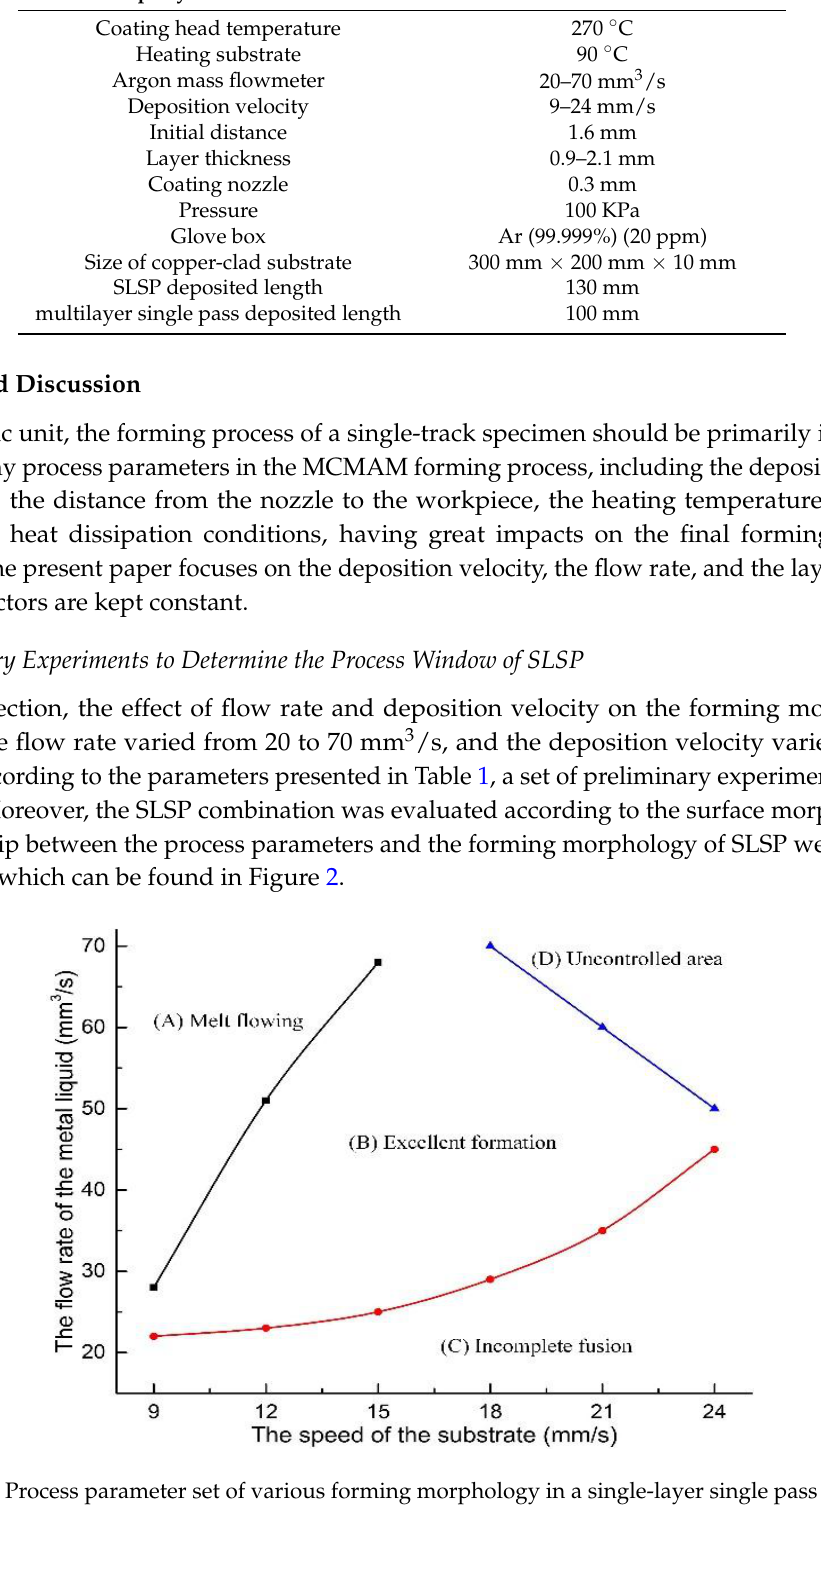
( d ) Figure 3. Various forming morphology with different combinations of process parameters. ( a ) Melt flowing. ( b ) Excellent formation. ( c ) Incomplete fusion. ( d ) Uncontrolled area. 3.2. Influence of the Distance Between the Nozzle and the Top Surface of the Previous Layer In this section, only the layer thickness is discussed in order to maintain other parameter consistency. One goal of this experiment was to achieve multilayer deposition. After one layer was deposited, the platform was moved downward for a distance in the z -direction, and another layer was deposited over the previous one. The forming process of the MLSP is more complicated than the SLSP due to the complex morphologies of the pre-deposited layer. In this section, the forming process is based on the optimized process windows of the SLSP. Each thin-walled specimen has twelve layers that are 100 mm in length. If the forming defect occurs in the current layer, the forming process must be terminated.